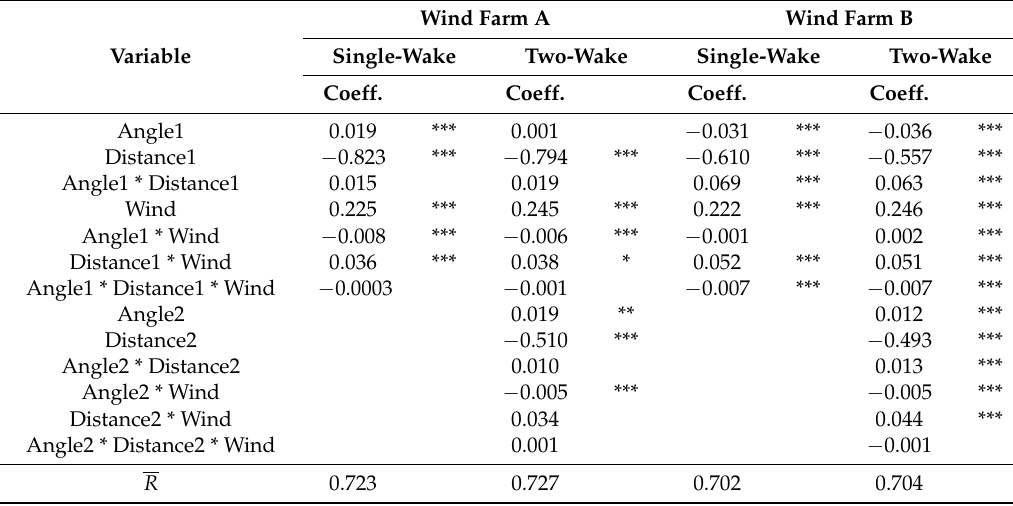
Table 3. Estimation results: regression